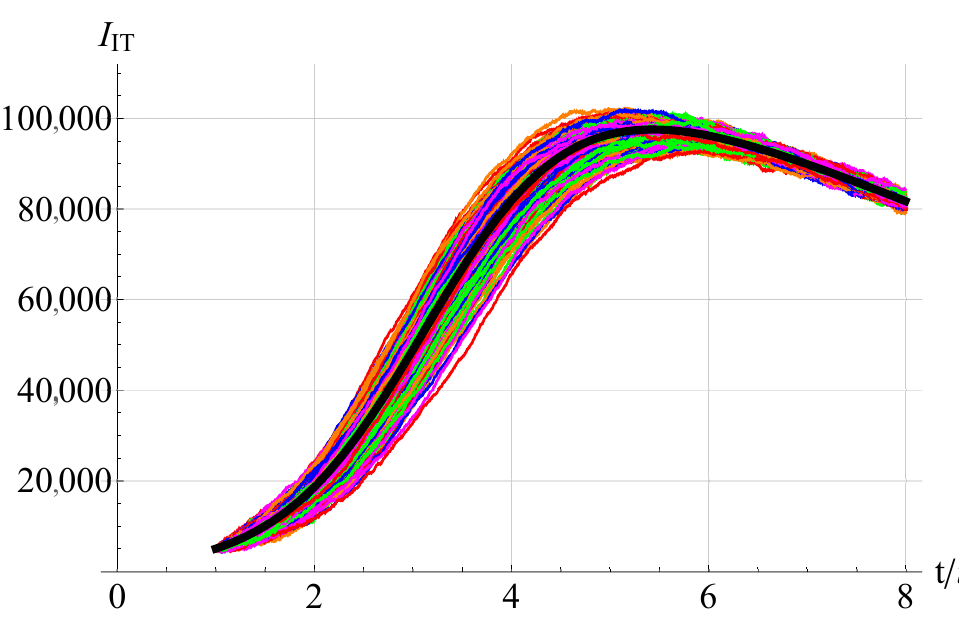
Figure 5. Stochastic equation for Italy. Sample paths of Equations (26) and (27) for Italy-first wave of infection by SARS-CoV-2 with η = 0.05 and for 200 realisations. The values of the other parameters are I 0 = 5,000, K = 150,000, α = 1.5, and β = 0.1, respectively. The black thick curve is the numerical solution of the deterministic Equation (15).